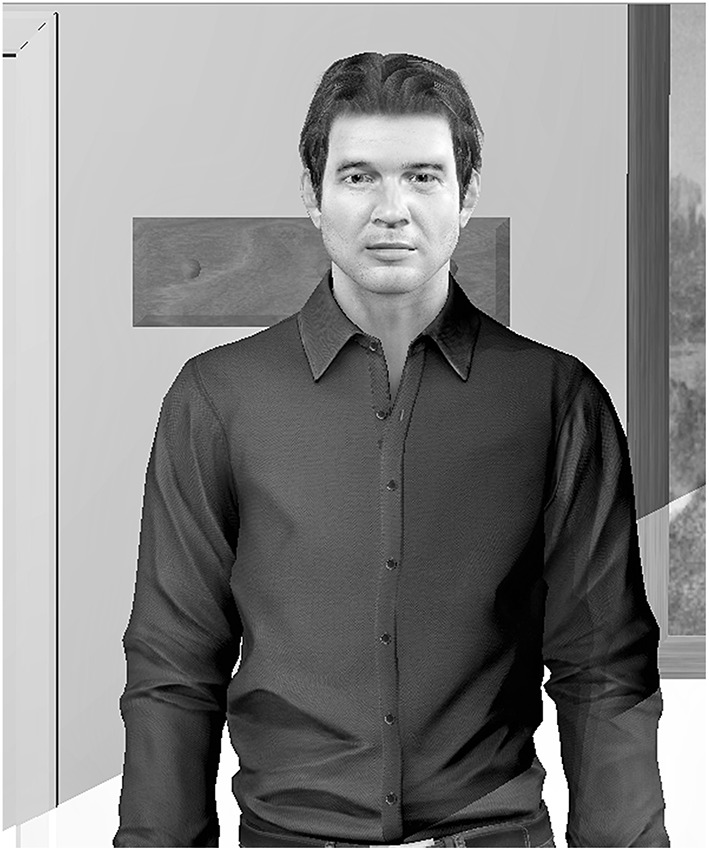
The avatar (“Brad”) used as a virtual agent in the present experiment (Hartholt et al., 2013).